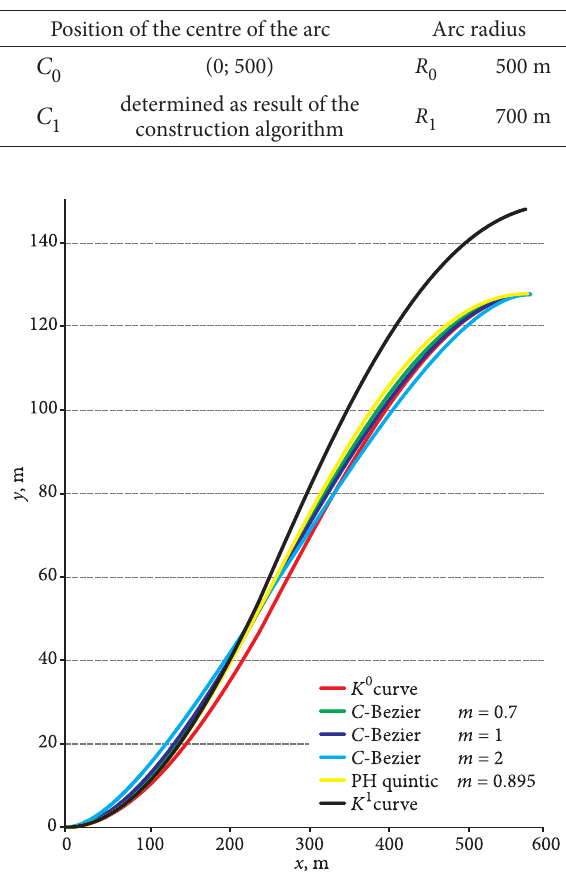
Fig. 10. Horizontal ordinates y(x) chart for S -shaped